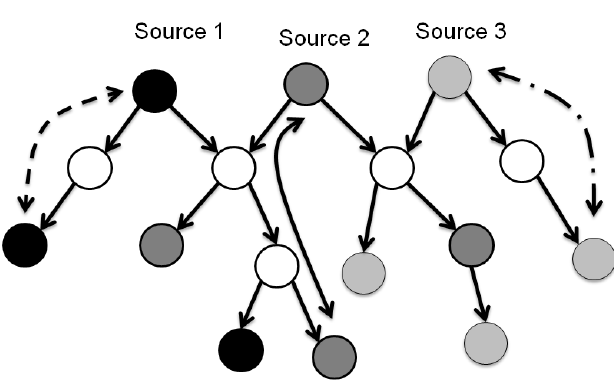
Figure 5. Multicast sensor